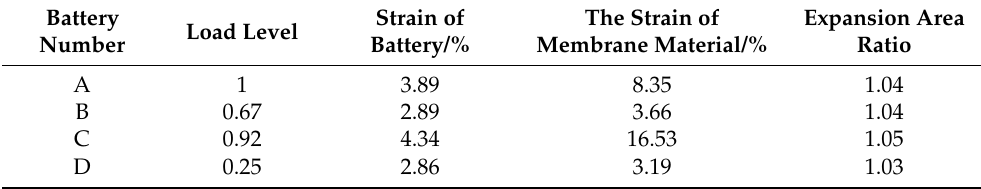
Table 2. Parameters when voltage drops to